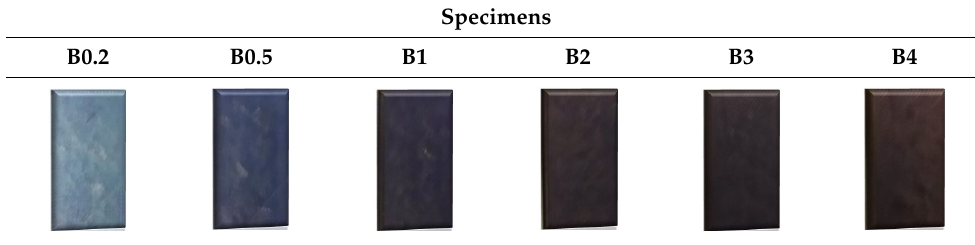
Figure 6. Spectral curves of blue hue specimens (legend according to Tables 8 and 9). Table 8. Specimens dyed with Disperse blue 27 (DB27).